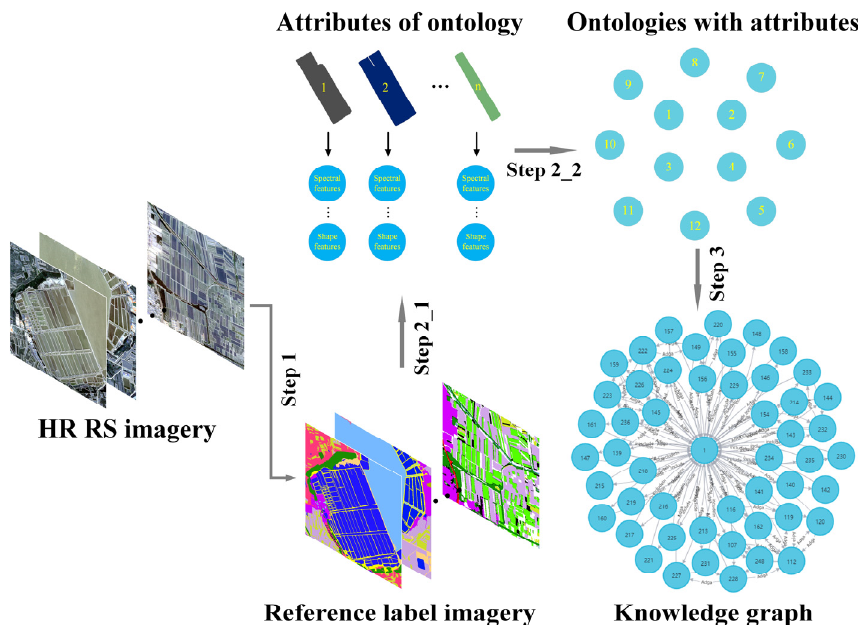
Figure 3. Process of knowledge graph construction. HR RS imagery represents high resolution remote sensing imagery. Step 1, Step 2_1, Step 2_2, and Step 3 are the construction of the reference image, attribute extraction, ontology establishment, and integration of spatial relationships, respectively. The 1, 2, …, n in ontologies and attributes are the unique identifiers assigned to each image object, while the 1, 2, …, n in the knowledge graph represent each ontology.